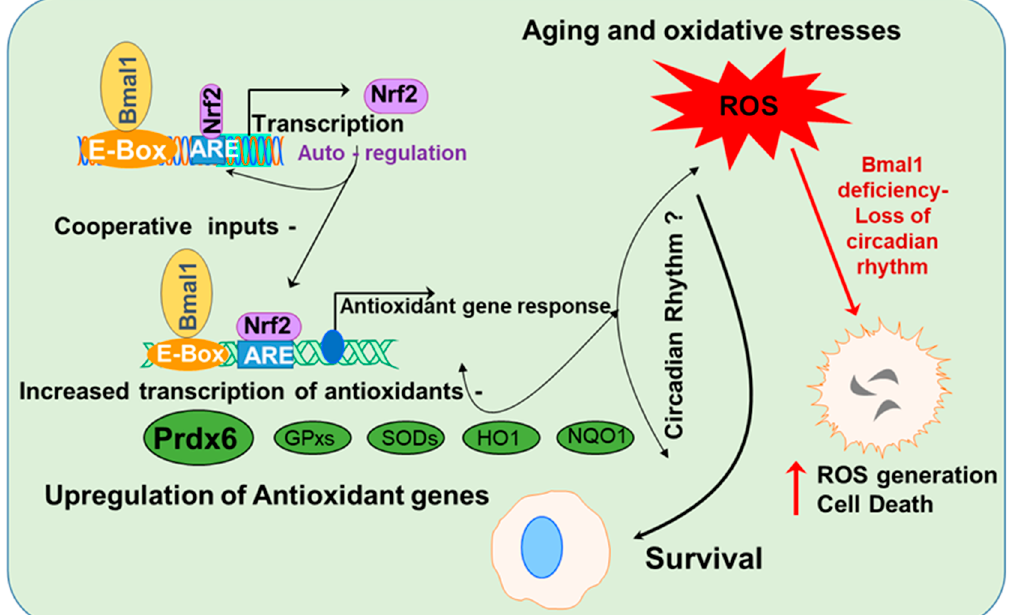
Figure 10. Illustration of proposed model for Bmal1 and Nrf2-mediated cellular protection against environmental stresses or aging. We observed that the biological clock gene, Bmal1 is crucial in promoting the antioxidant gene transcription in mouse lens / hLECs. Here we show plausible direct and indirect mechanism in which Bmal1 may defend the lenses / LECs by regulating antioxidant genes. In direct mechanism, Bmal1 directly regulates the antioxidant genes like Prdx6 transcription by binding to its E-Box elements. In indirect mechanism of regulation, Bmal1 regulates the expression of Nrf2 through E-Box elements present in the promoter region. Then Nrf2 activates antioxidant defense by binding to the ARE sequence present in the promoter region of the target antioxidants, here Prdx6. Our work revealed that both Bmal1 and Nrf2 regulate Prdx6 transcription; we proposed that cooperativity of Bmal1 and Nrf2 is an important phenomenon for peaking Prdx6 expression and cellular protection. Additionally, our findings reveal that molecular clock controls the Nrf2 and its antioxidant targets, like Prdx6 expression levels, to defend lens / hLECs by controlling ROS